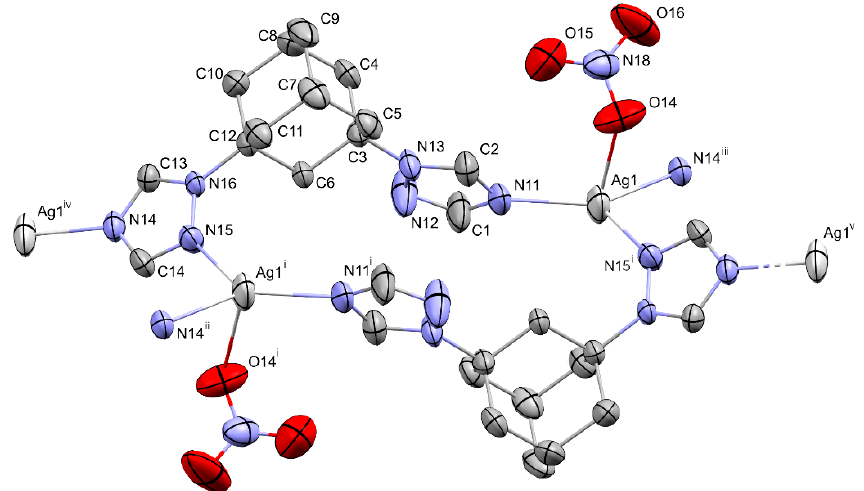
Figure 1. Fragment of crystal structure of coordination polymer 1 showing thermal ellipsoids (at 50% probability level) and labels for non-hydrogen atoms. Hydrogen atoms and the second position of nitrate ion are omitted for clarity. Symmetry operations: i (1 − x , 1 − y , 1 − z ); ii (2 − x , − 0.5 + y , 1.5 − z ); iii ( − 1 + x , 1.5 − y , − 0.5 + z ); iv (1 + x , 1.5 − y , 0.5 + z ); v (– x , − 0.5 + y , 0.5 − z ).